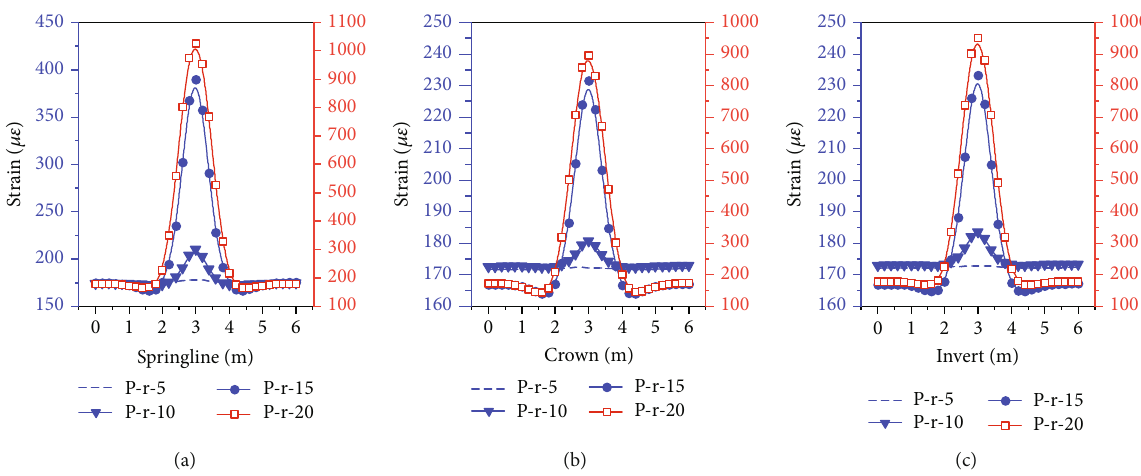
Figure 14: Strain of steel cylinder under combined loads: (a) spring; (b) crown; (c) invert.